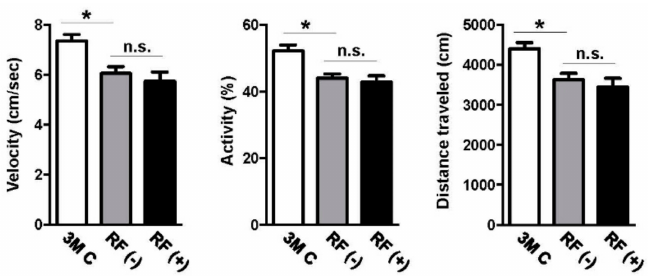
Figure 6. Effects of RF-EMF exposure on general locomotor behavior of aged mice. The young-aged control (3M C, n = 3) group showed increased locomotor activity compared with that of aged mice. However, average velocity ( left ), activity ( center ), and total track length ( right ) did not differ between sham-exposed (RF ( − ), n = 12) and RF-exposed (RF (+), n = 12) groups. The values are presented as means ± SEM. * p < 0.05 versus young-aged (3M C) group. n.s.: no